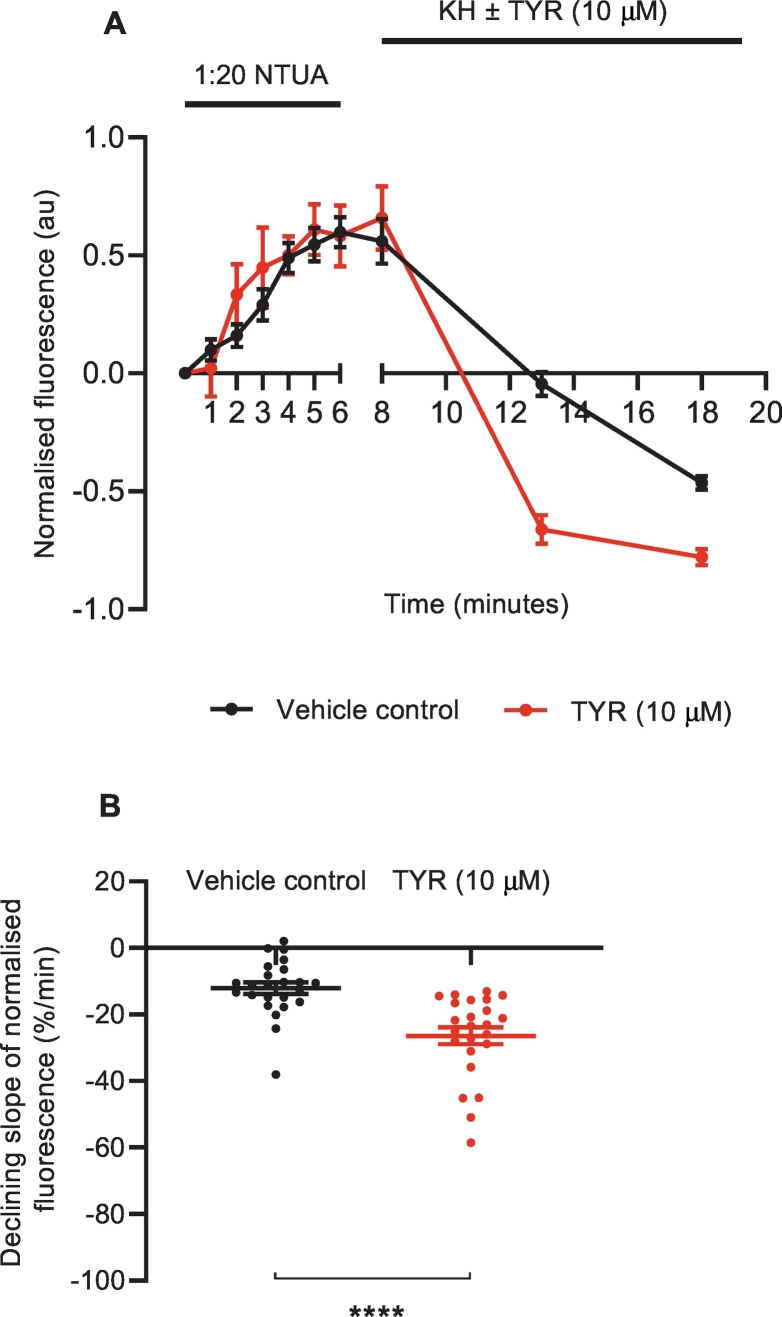
NET substrate tyramine induced rapid loss of intra-terminal fluorescence in mouse LAA.Mouse LAA were subjected to 1:20 NTUA test period for 6 min and promptly returned to KH with or without tyramine (10 μM) and imaged in 5 min intervals. After 5 min, the loss of fluorescence in the TYR group was significantly faster than in the control group. Within 10 min of TYR exposure, fluorescence of some nerve terminals was completely lost as the slope tended towards −1, while they remained visible in the control group (A). The gradient variables were extracted for the first 5 min and quantified in B.Control (n = 4, nt = 24) vs. TYR (n = 4, nt = 24).Data presented as mean ± SEM. **** denotes p < 0.0001. Unpaired t-test.